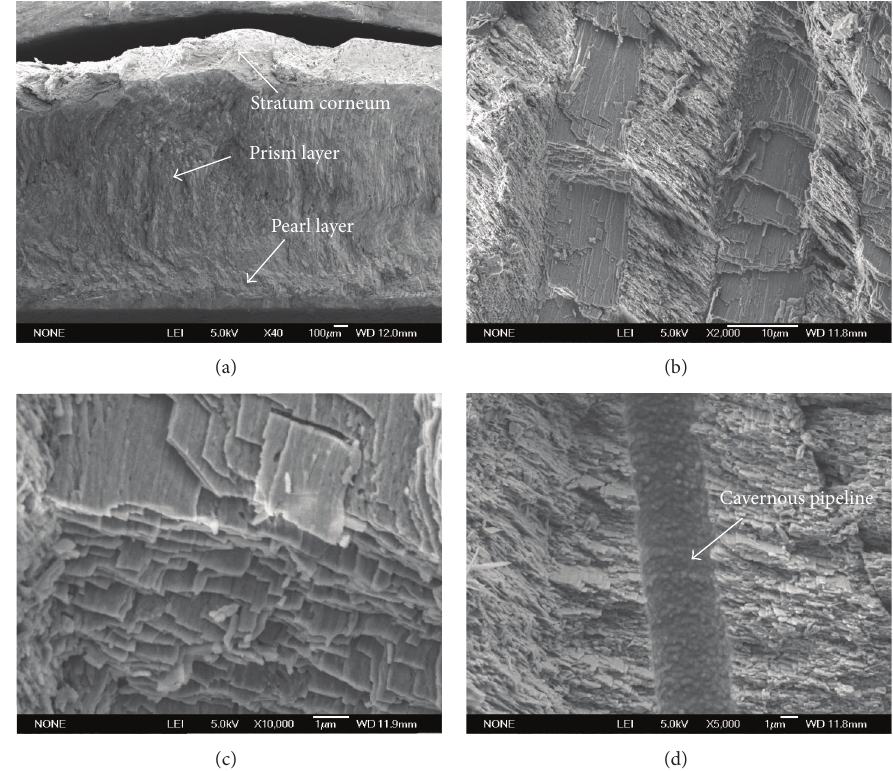
Figure 12: Microstructure of Scapharca subcrenata shell from cross-section: (a) the microstructure of the Scapharca subcrenata shell; (b) the first-order platelets of the crossed lamellar layer of prismatic layer; (c) the second-order lamellae of the crossed lamellar layer; and (d) the nacre layer and a typical pore canal tubule.